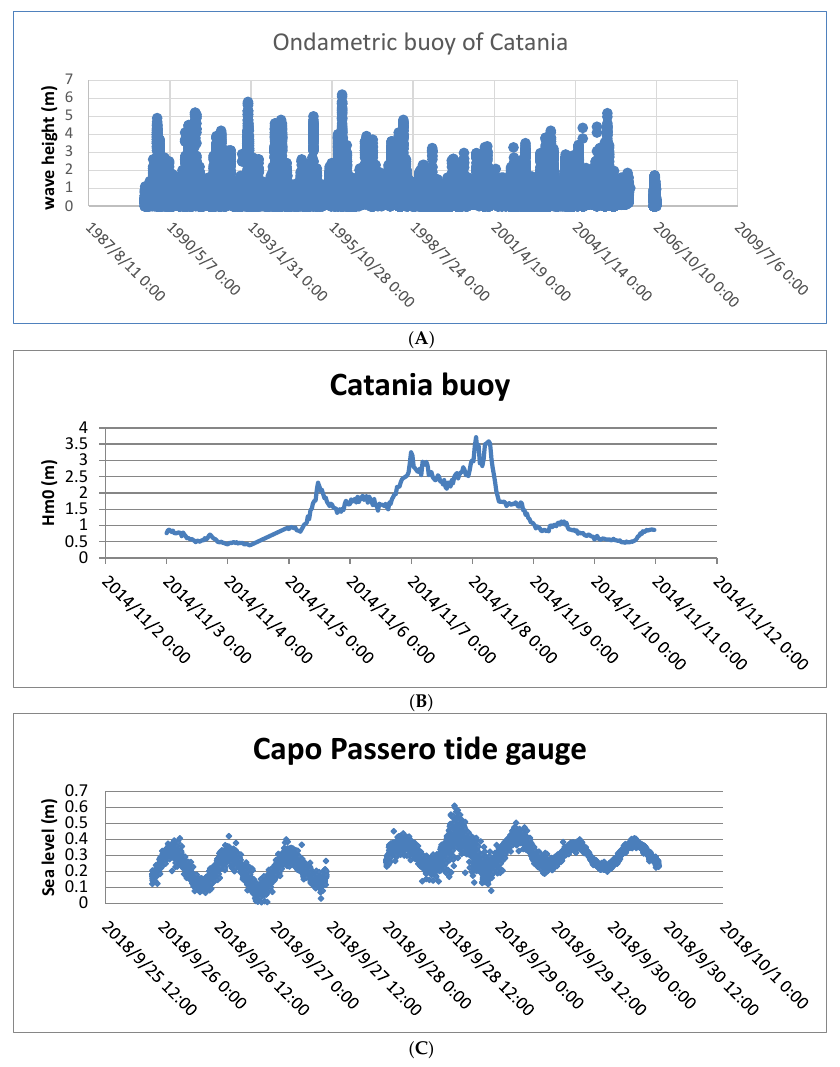
Figure 2 . Meteo-marine features recorded in Southeastern Sicily. ( A ) Data of significant spectral wave heights Hm0 recorded by ondametric buoy of Catania (1986–2006). ( B ) Wave height Hm0 recorded by Catania buoy (RON) during Medicane Qendresa. ( C ) Sea level recorded by tide gauge of Capo Passero (ISPRA [72]) during Medicane Zorbas.